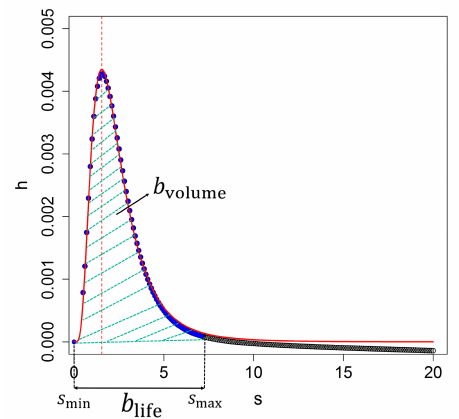
Figure 4. The blob volume b volume and the blob lifetime b life . A blob volume is the area below the fitted model f 3 ( s ) at scale direction profiles h ( s ). The vertical dashed line indicates the location of the maximum t 0 from model f 3 ( s ) (dashed line red color). Closed blue symbols show the range [ s min , s max